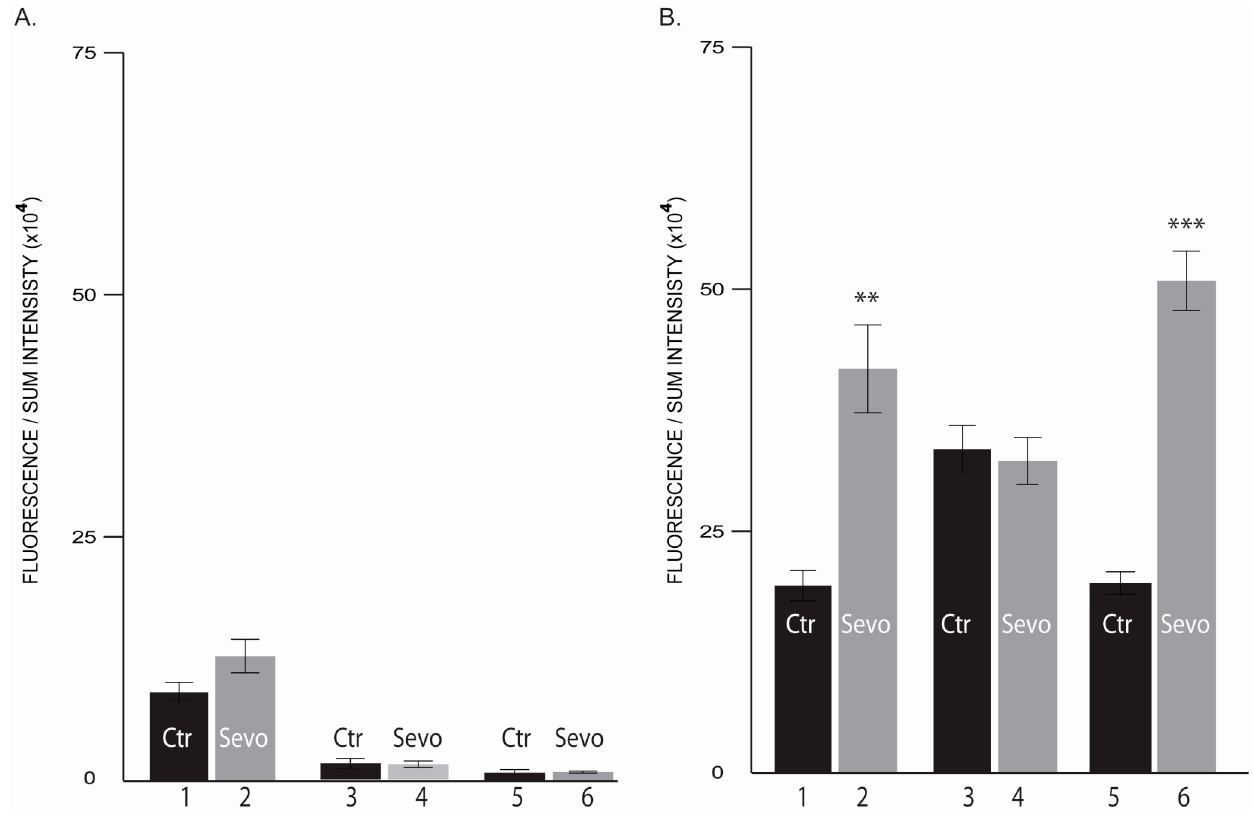
Figure 6. Level of Vimentin. ( A ) Normal mammary cells MCF-10A; ( B ) human breast adenocarcinoma cell line MDA-MB231 (1, 2–6 h; 3, 4–24 h; 5, 6–72 h; Ctr-untreated cells; Sevo-treated cells with 2 mM sevoflurane; h-hours). ** p < 0.005; *** p < 0.0005. n = 2.